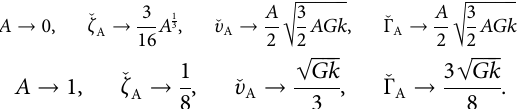
Figure 7 is a plot of the scaled curvature of the Atwood number A for the special critical, convergence limit, minimum shear, Taylor, Layzer-drag and Atwood bubbles. Figure 8 shows plots of their corresponding velocities and shear